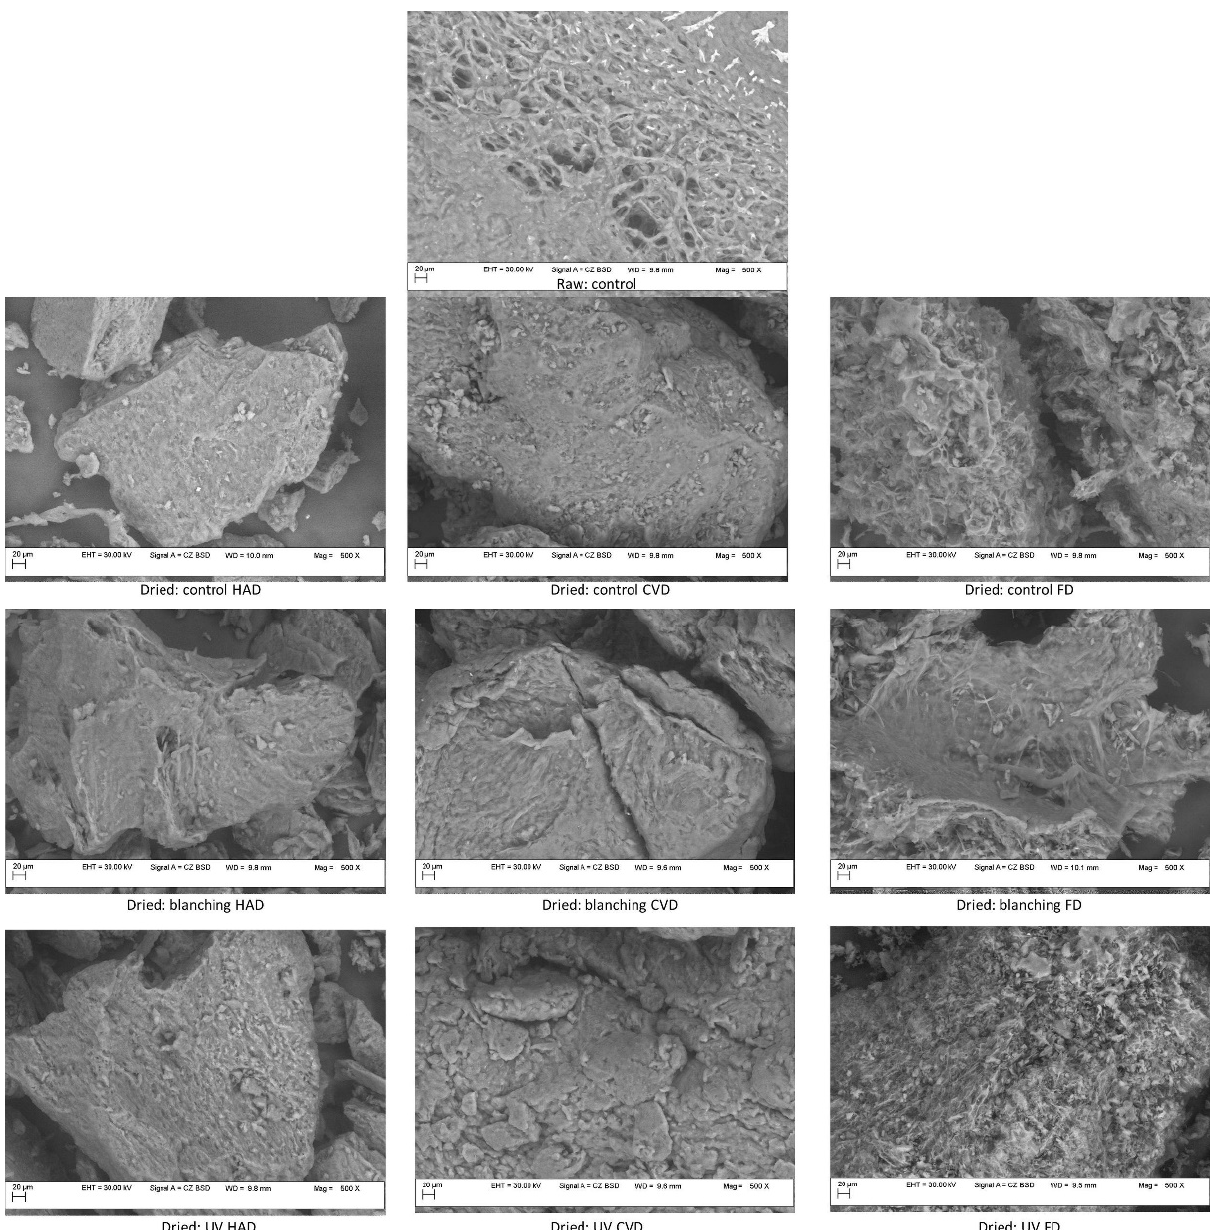
Figure 5. The SEM micrographs of raw and dried B. edulis mushrooms under different pretreatment and drying methods (500×).